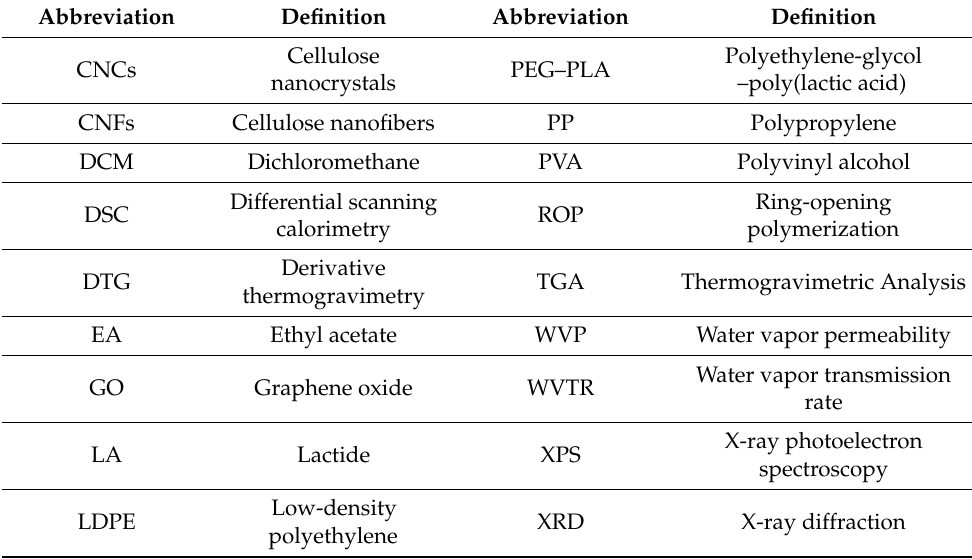
Table A1. List the abbreviations used in this